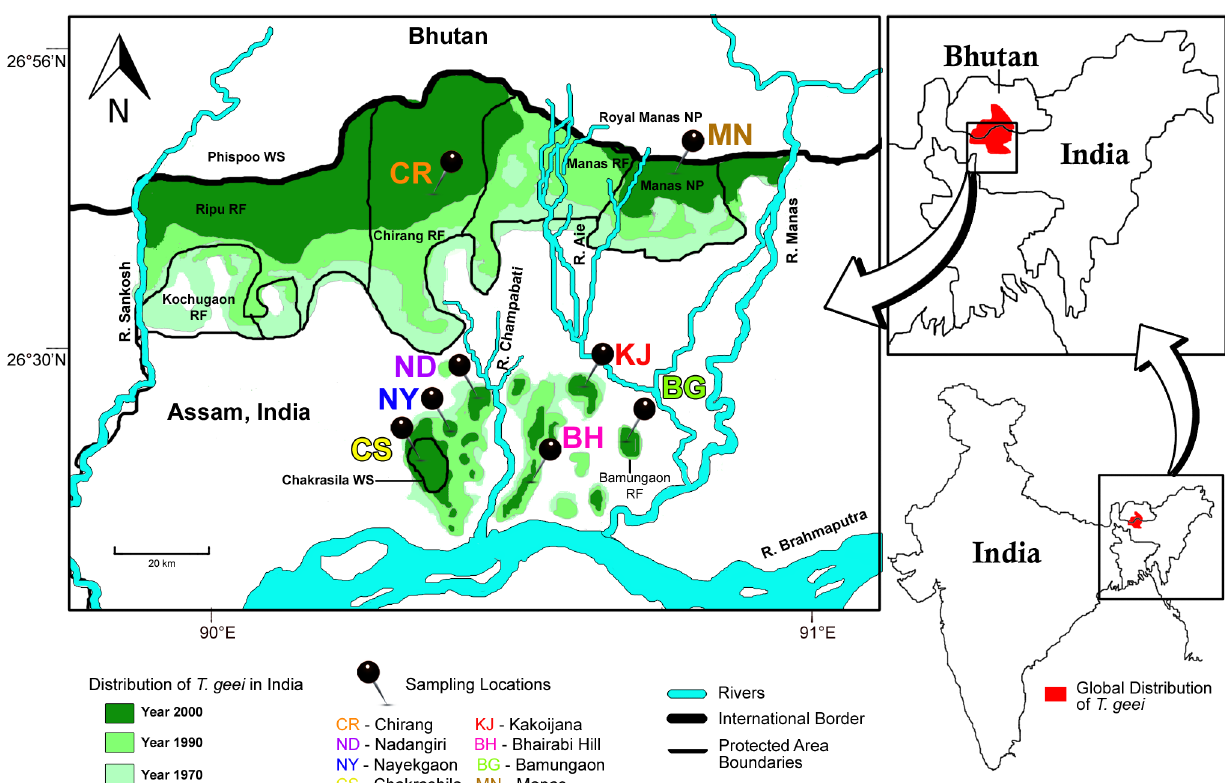
Fig 1. Study area and sampling locations. Current and past distribution of golden langur in Assam, India based on previous reports [4] and sampling locations in the present study. Umananda (UM) is not shown in this map. Modified and reprinted from Choudhury et al 2002 [4]